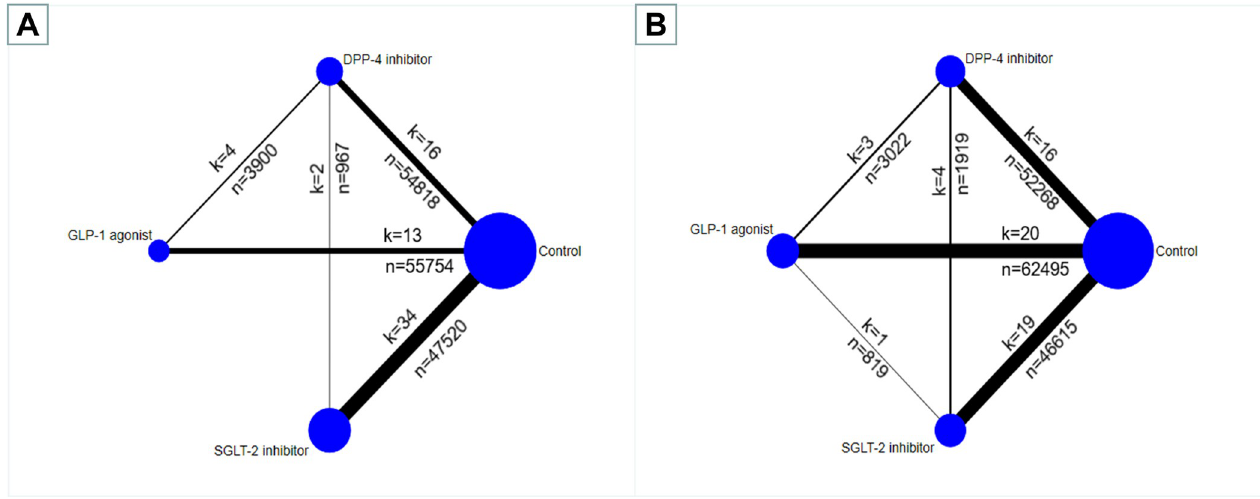
Fig 2. Network meta-analysis of eligible comparisons for composite renal events (A) and AKI events (B).